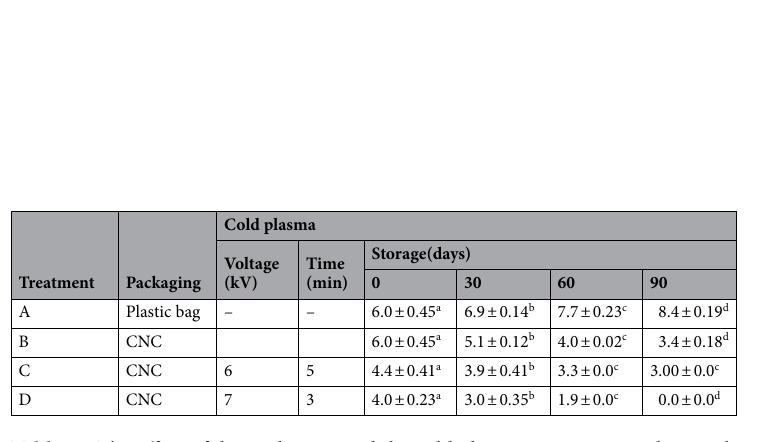
Table 1. The effect of the packaging and the cold plasma treatment on the number of E. coli cells (Log CFU/ gr). A: The Saffron is packed in a plastic bag without any treatment and stored for 30, 60, and 90 days (control). B: The Saffron is packed by CNC package without any treatment and stored for 30, 60, and 90 days. C: The CNC packed Saffron is treated by cold plasma for 5 min at 6 kV and stored for 30, 60, and 90 days. D: The CNC packed Saffron is treated by cold plasma for 3 min at 7 kV and stored for 30, 60, and 90 days. The number of E. coli cells was enumerated. abcd means in the same row followed by different superscript letters are significantly different ( P < 0.05). Data represent the mean ± standard deviation of each sample (n =